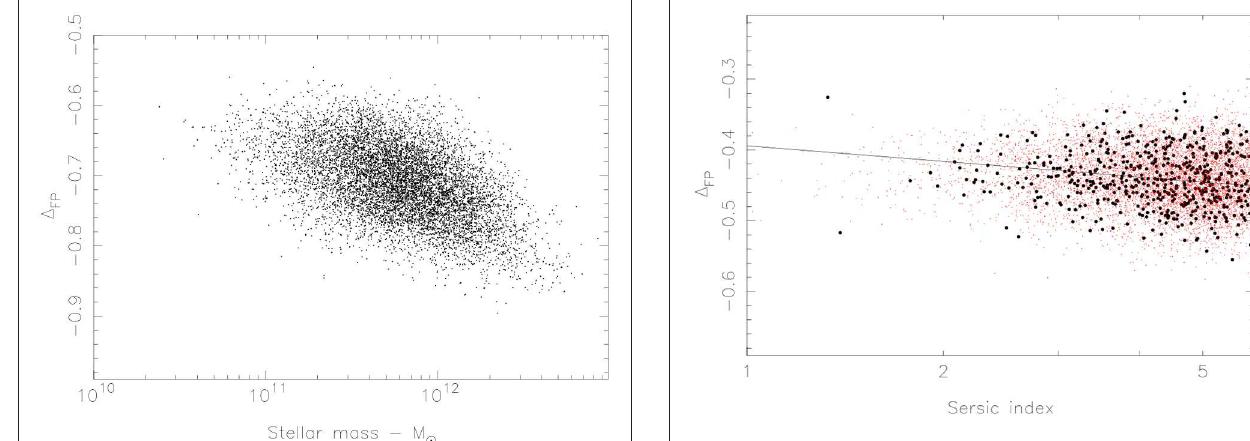
FIGURE 3 | Deviation from the virial plane. To separate resolution effects, the apparently largest 541 galaxies are filled black symbols and the line is a least squares fit.